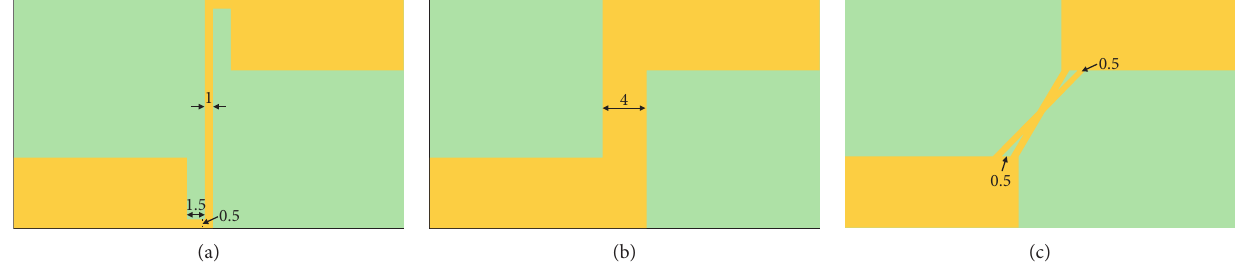
Figure 6: Schematic diagram of the connection structure of the two ground planes. (a) A1. (b) A2. (c) A3.